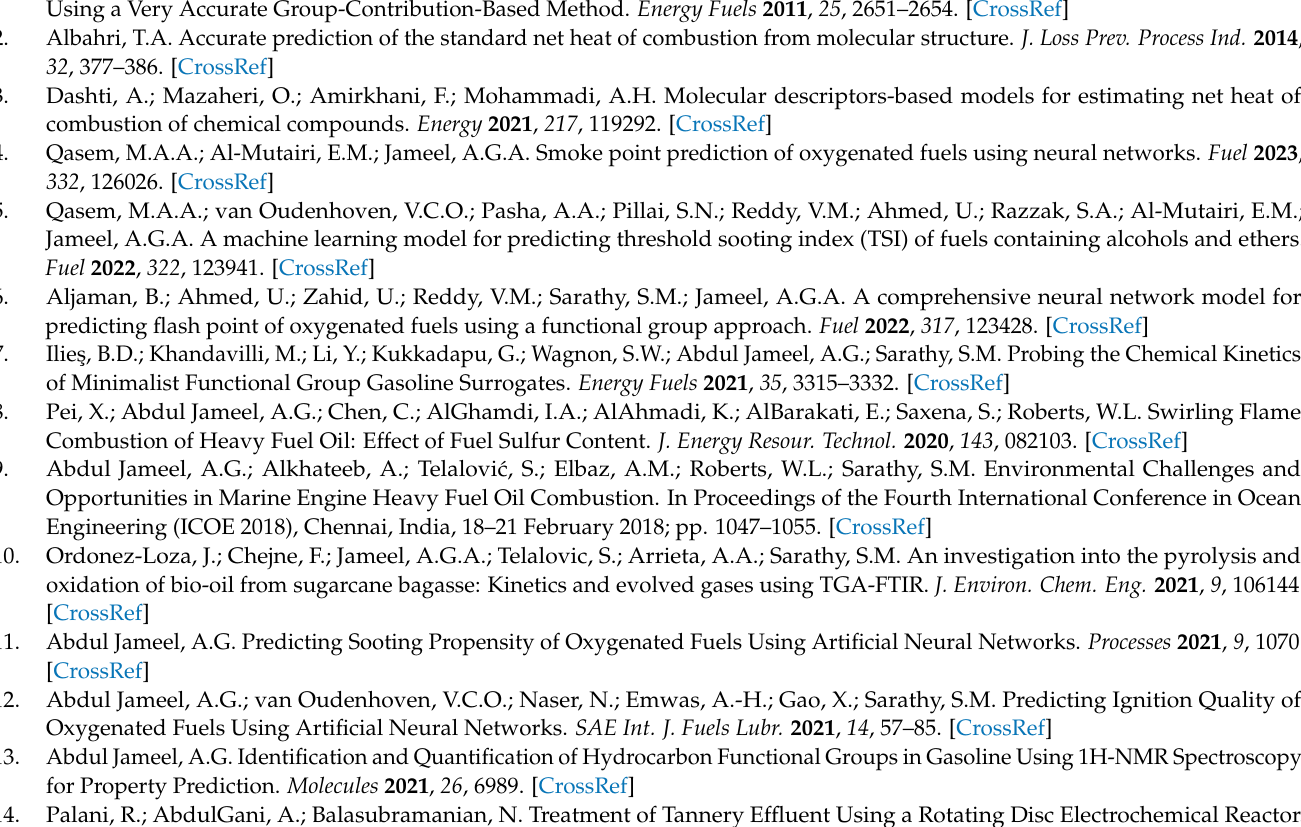
Table S3. Enthalpy of combustion for surrogates Shrestha (2014) [19], Table S4. Enthalpy of com- bustion for surrogates Kalghatgi et al. (2011) [20], Table S5. Enthalpy of combustion for surrogates Huber et al. (2010) [21], Table S6. Enthalpy of combustion for surrogates Eddings et al. (2005) [22], Table S7. Enthalpy of combustion for surrogates Naik et al. (2010) [23], Table S8. Enthalpy of com- bustion for surrogates Grubinger et al. (2021) [24], Table S9. Enthalpy of combustion for